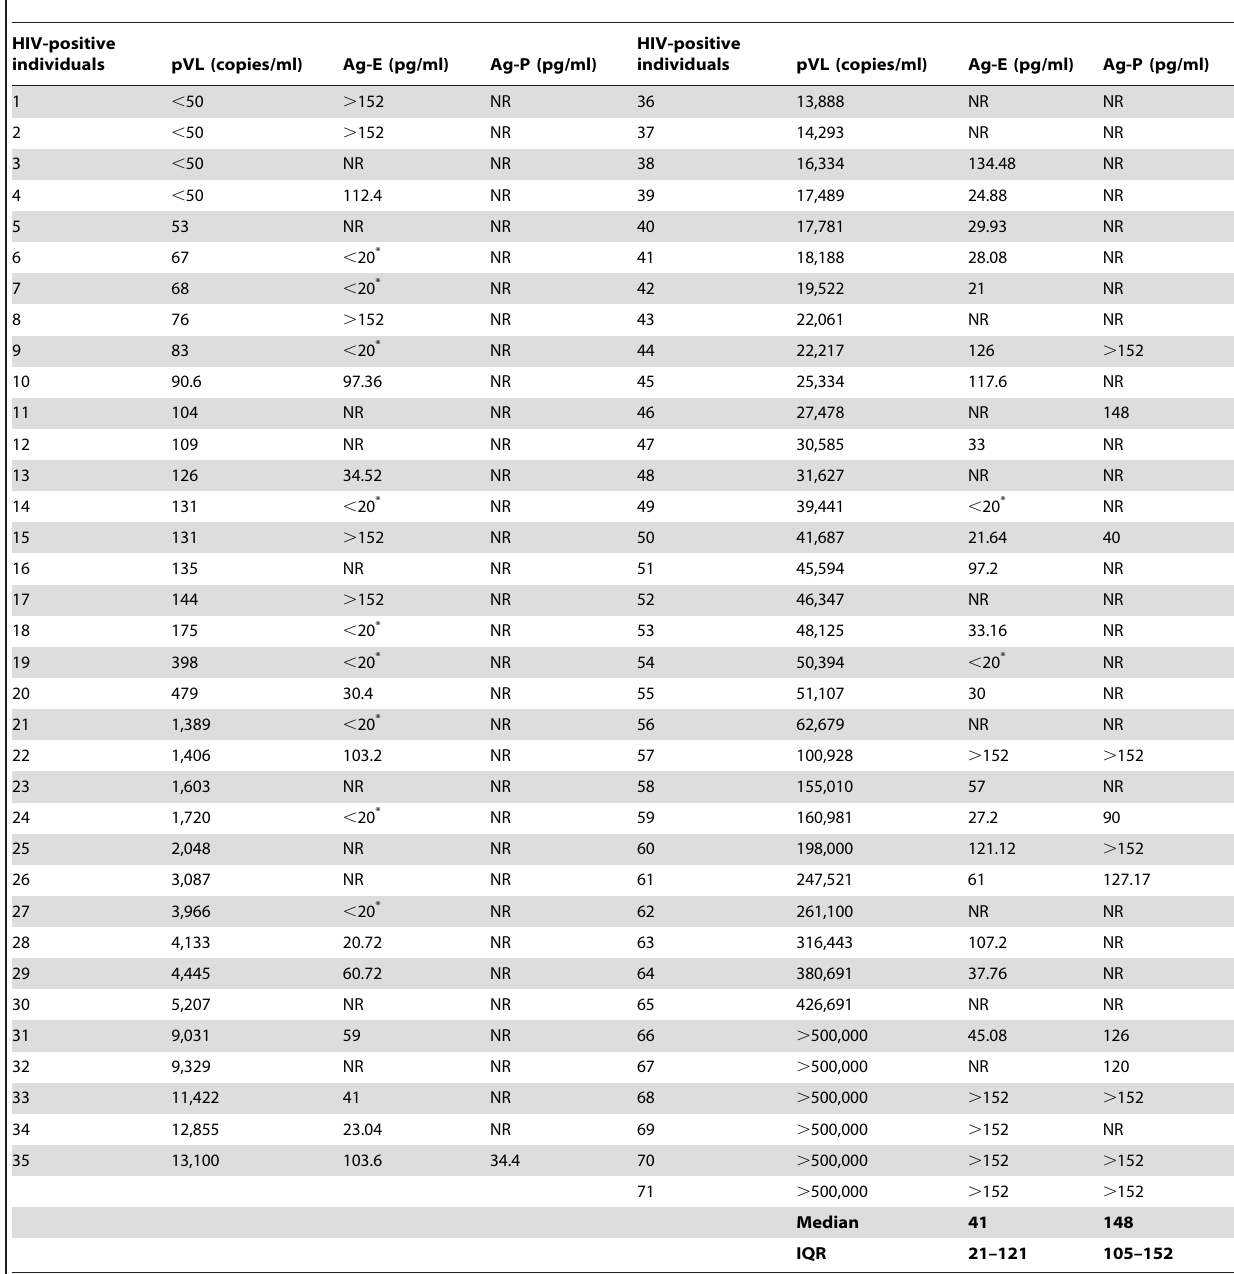
Table 1. Plasma viral load and p24-antigen in plasma and erythrocytes from individuals with detectable plasma viral load in at least one sample during the year prior to the